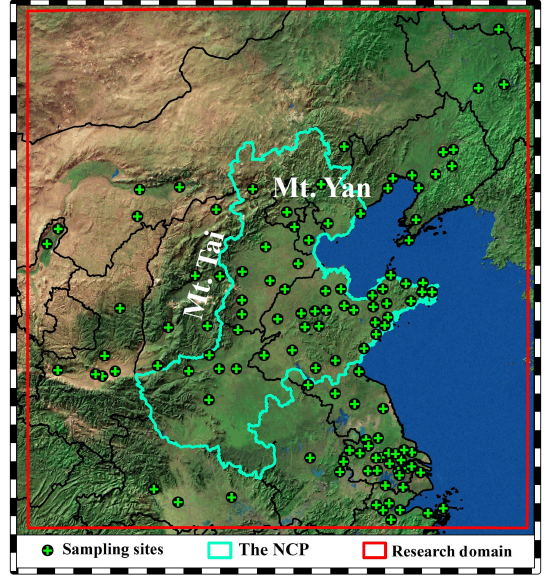
Figure 3. The horizontal domain of the model (WRF-CHEM), with the location of sampling sites (shown by the green crosses) and to- pographical conditions of the NCP, which are surrounded by the mountains of Yan and Tai in the north and west,